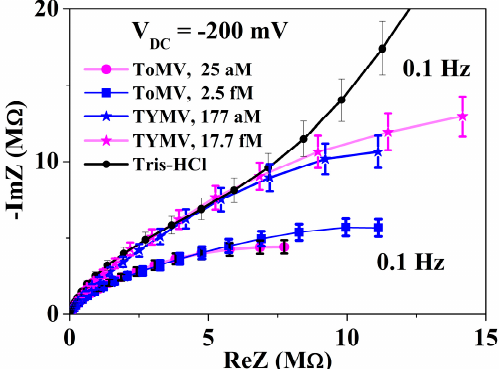
Figure 3. ( a ) NPs read out at V DC = − 200 mV and t = 0 min, i.e., soon after the bias application in blank TRIS-HCl buffer and in ToMV and TYMV—Based suspension droplet at two representative concentrations (see legend). The NPs response was different depending on the virus embedded in the suspension and with respect to suspending medium.